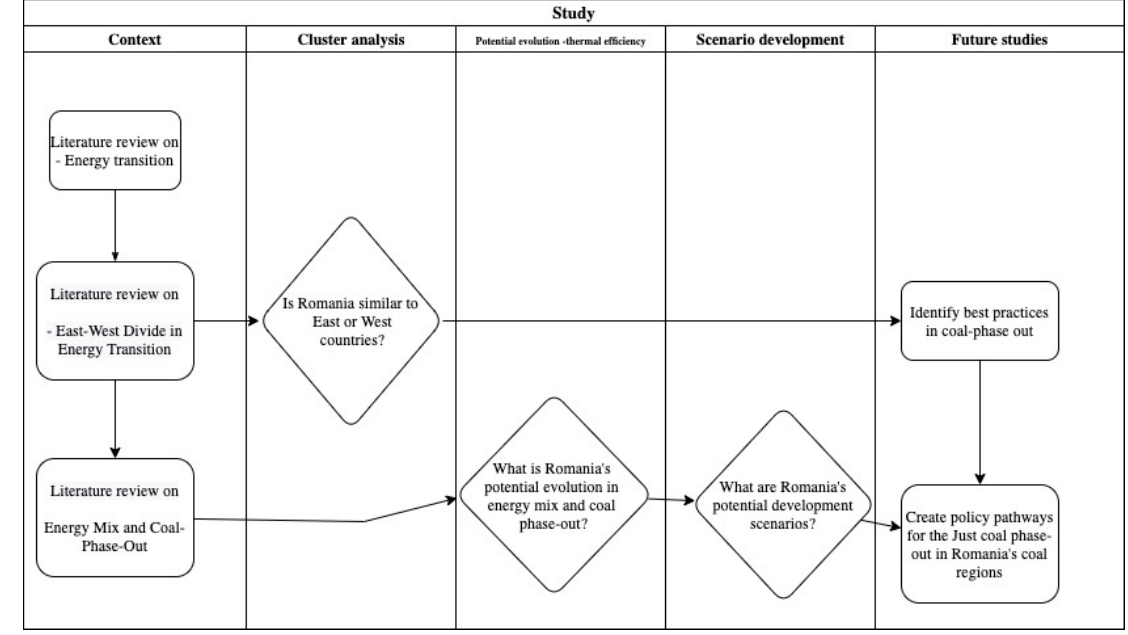
Figure 2. Methodological framework for the analysis—logical diagram.